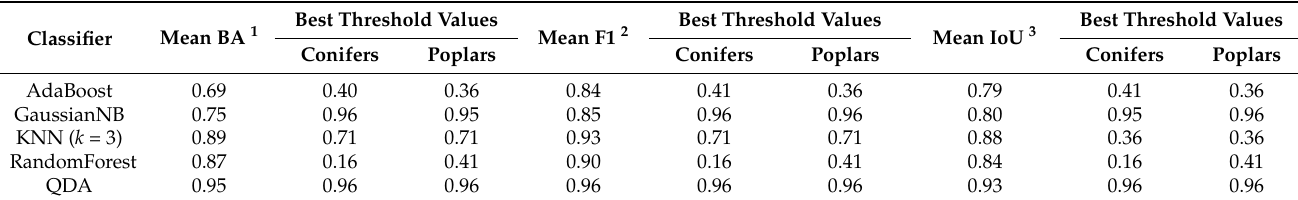
Table 2. Comparison of ML methods with grey level co-occurrence matrices (GLCM) feature engineering. Classifier